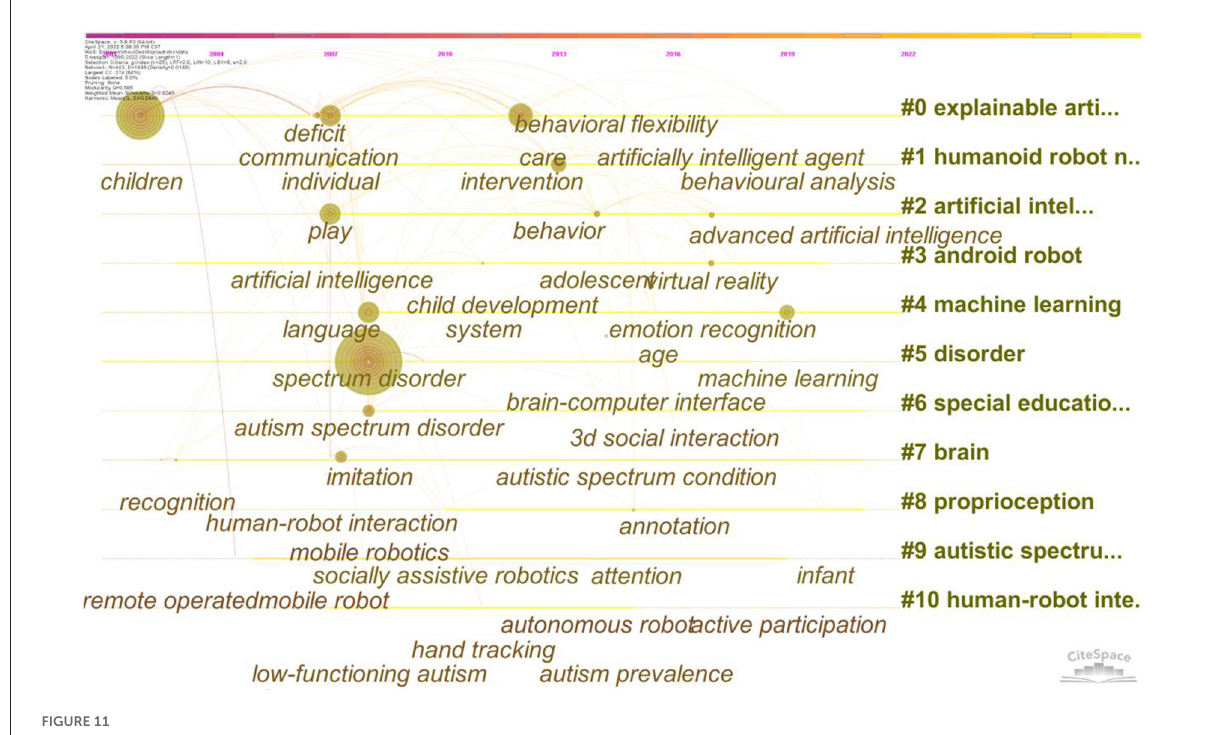
FIGURE11 The cluster timeline view network of keywords related to Al on